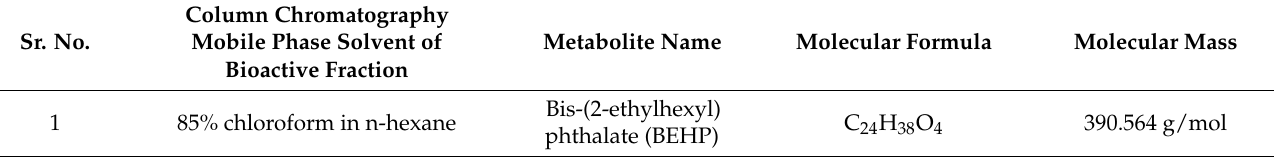
Table 1. Details of the column chromatography and purified metabolite.